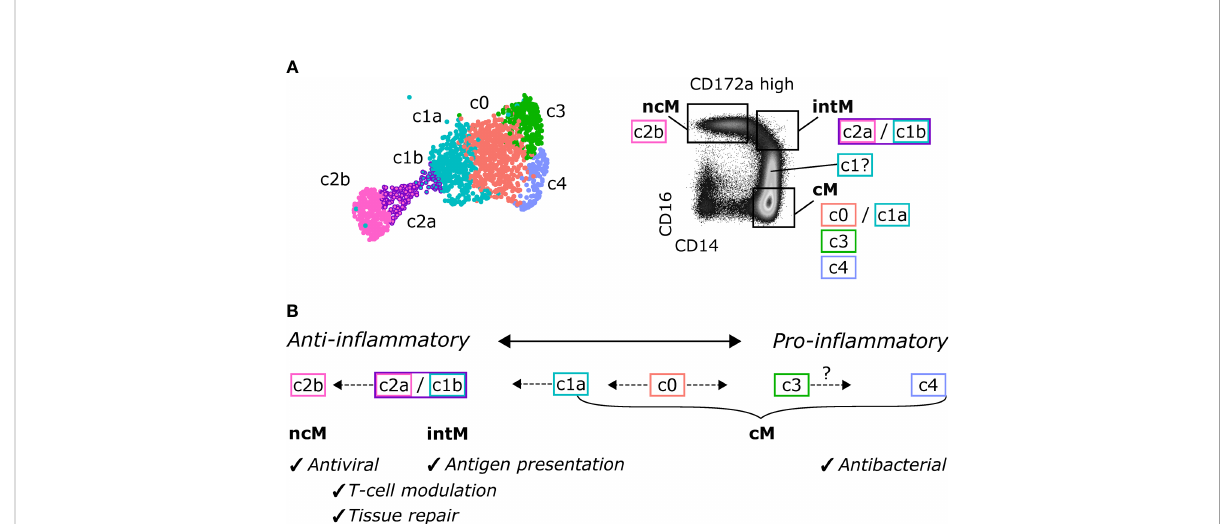
FIGURE 8 Proposed continuous differentiation and proposed functional specialization of bovine monocyte subsets. (A) Assignment of scRNA-seq clusters to CD14/CD16-de fi ned monocyte subsets, as sorted for bulk RNA-seq. (B) Proposed differentiation pathways. A subcluster of cM (c0) may give rise to anti-in fl ammatory intM and ncM with specialized functions in antigen presentation and antiviral responses, respectively, and to pro- in fl ammatory subclusters of cM with prominent antibacterial